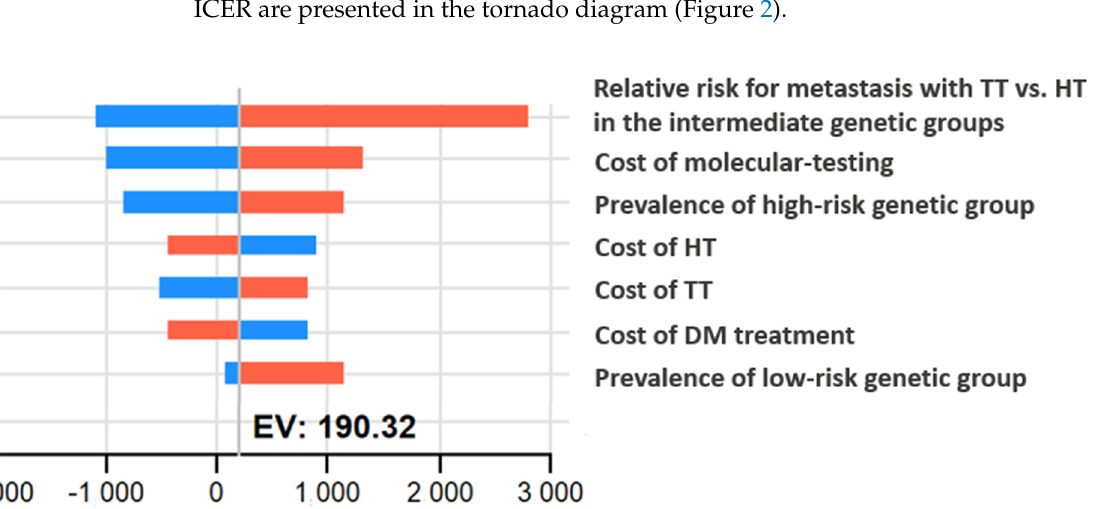
Table 2. Models’ results—cost and effectiveness of genetic testing for lrDTC. Strategy Cost Without genetic testing 75,103 22.256 With genetic testing 75,430 327 23.972 1.716 190 Costs in USD; ICER: incremental cost-effective ratio.